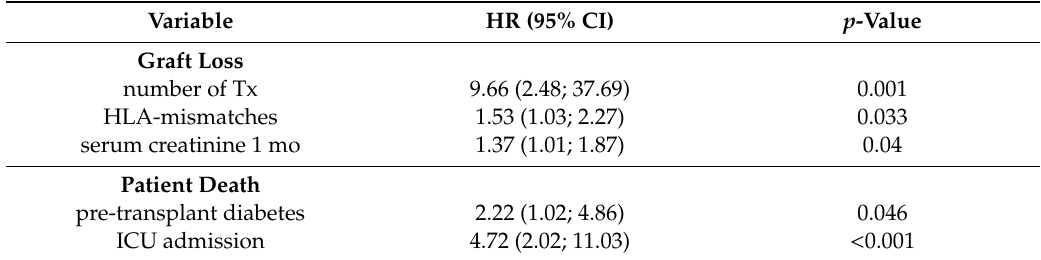
Table 5. Significant impact factors on graft loss and patient death in multivariate cox regression.